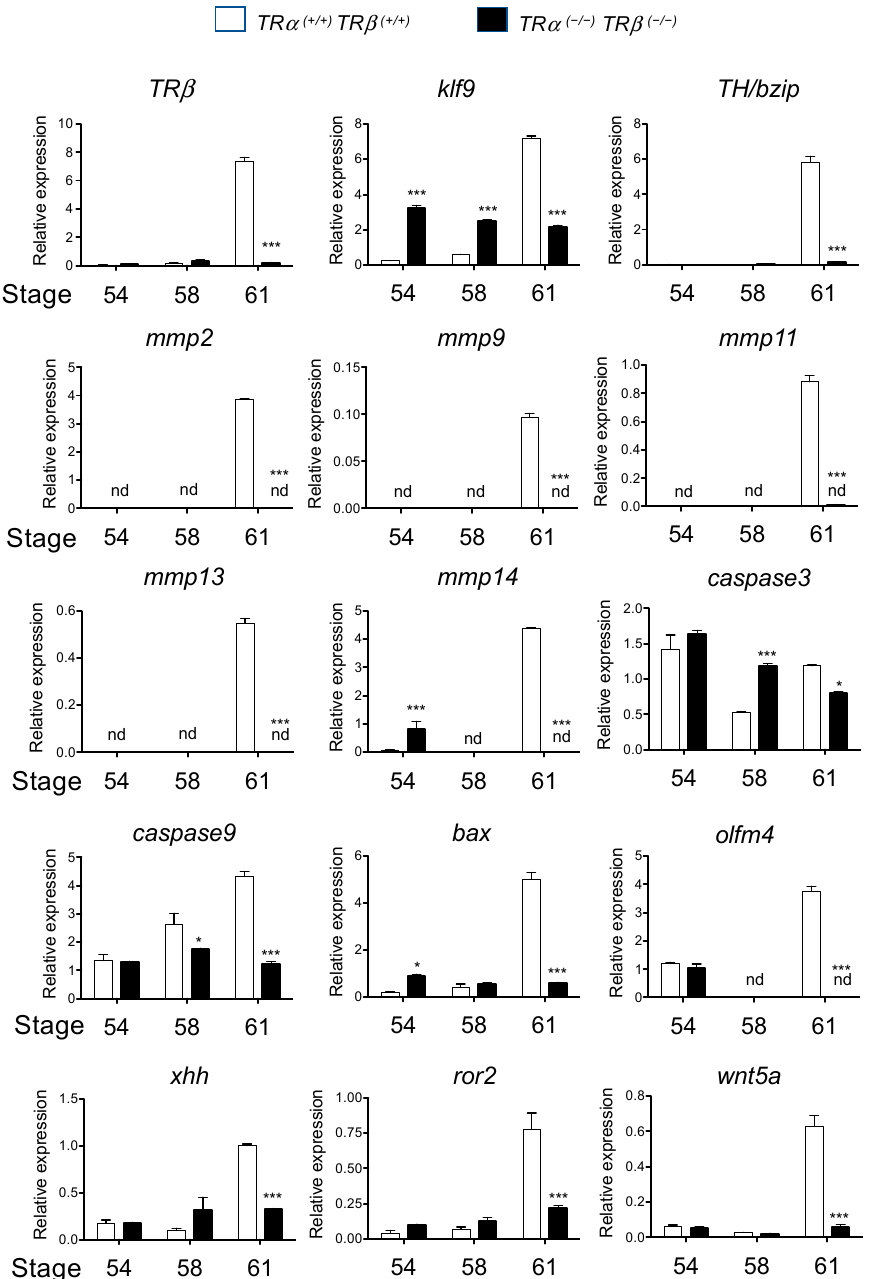
Figure 5. T3 response genes fail to be upregulated in the intestine of TRDKO tadpoles during metamorphosis. Total RNA was isolated from the intestine of wild-type and TRDKO tadpoles at stage 54, 58, and 61, and used for real-time RT-PCR analysis of the expression of known T3 direct-target genes: TR® , klf9 , and TH/bzip ; genes related to extracellular matrix remodeling: mmp2 , mmp9 , mmp11 , mmp13, and mmp14 ; apoptosis-related genes: caspase 3 , caspase 9, and bax ; adult stem cell marker genes: sonic hedgehog ( xhh ) and olfm4 , and cell dedifferentiation-related genes: ror2 and wnt5a . The mRNA levels were normalized against that of rpl8 . The groups included 5 wild-type and 8 TRKDO animals. Note that the expression of all genes that are regulated during intestinal remodeling in the wild-type animals was essentially unchanged in the TRDKO animals. Asterisks (* and ***) indicate a significant difference determined by Bonfferoni comparison test ( p < 0.05 and p < 0.001). nd: Not